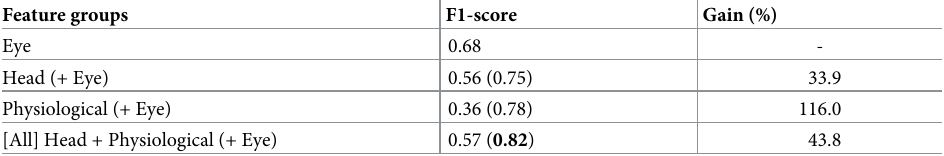
Table 3. Ablation study for cybersickness (addition of eye-tracking). Eye-tracking data already shows a strong rela- tionship with cybersickness, and when it is considered with other data modalities, the performance of the model signif- icantly increases. Gain indicates the increased ratio of the model performance after the addition of the eye-tracking data. Feature